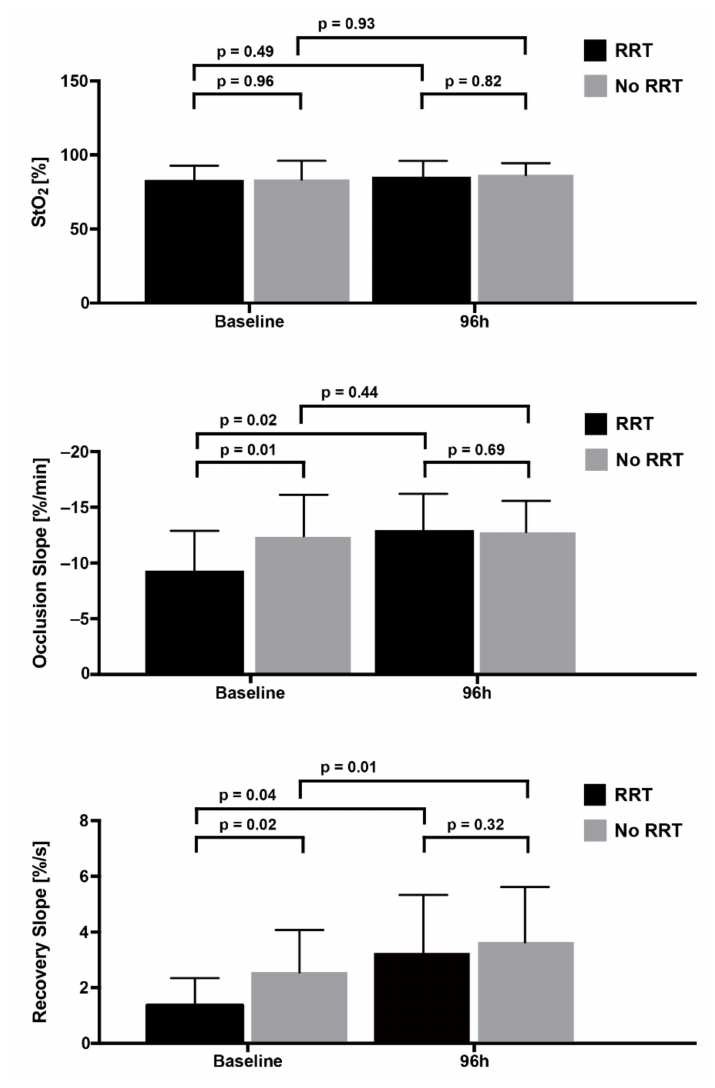
Figure 1. Unprovoked StO 2 and the VOT occlusion and recovery slopes at baseline and after 96 h, in the context of renal replacement therapy (RRT) status until day